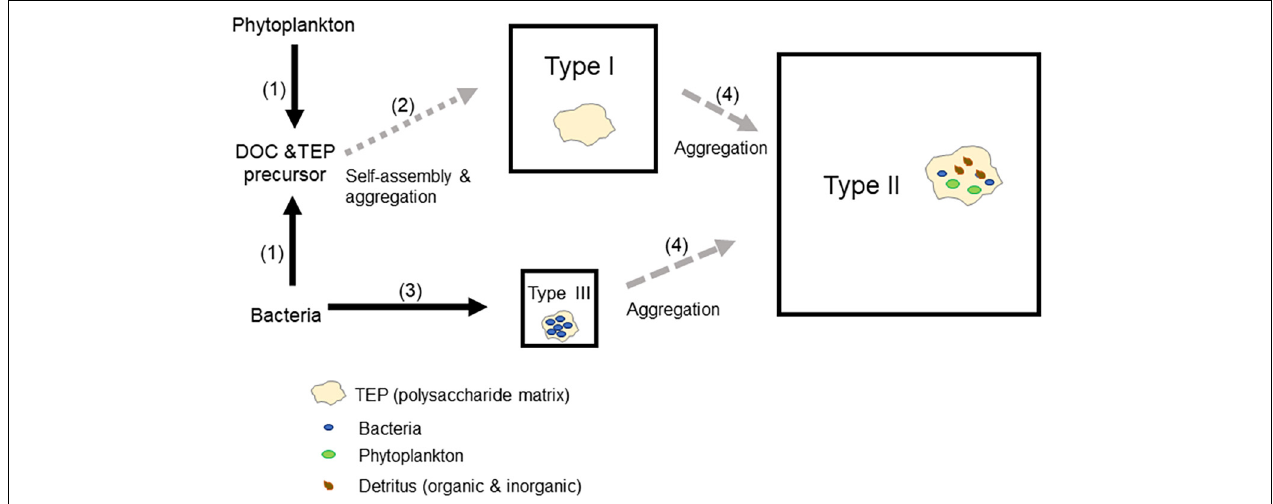
FIGURE 6 | A conceptual model to explain bacterial roles as drivers of transparent exopolymer particle (TEP) dynamics. (1) Both bacteria and phytoplankton produce TEP precursors (Passow, 2002a). (2) Type I TEPs are formed via the spontaneous formation of nanogels (Chin et al., 1998; Verdugo et al., 2004) and their subsequent aggregation (Burd and Jackson, 2009). (3) Bacteria contribute to the formation of Type III TEPs (Sugimoto et al., 2007). (4) Type I and Type III TEPs aggregate with various particles suspended in seawater (phytoplankton, bacteria, and organic and inorganic detritus), leading to the formation of Type II TEPs. The area of a square representing a TEP type reflects the percentage contribution of each type of TEP to the total TEP in terms of area (an average of all months and depths). Note that this scheme emphasizes TEP production pathways. Loss processes (e.g., bacterial degradation and grazing) and fragmentation processes (e.g., disruption of TEPs owing to turbulence and grazer-induced disturbance) are not depicted for